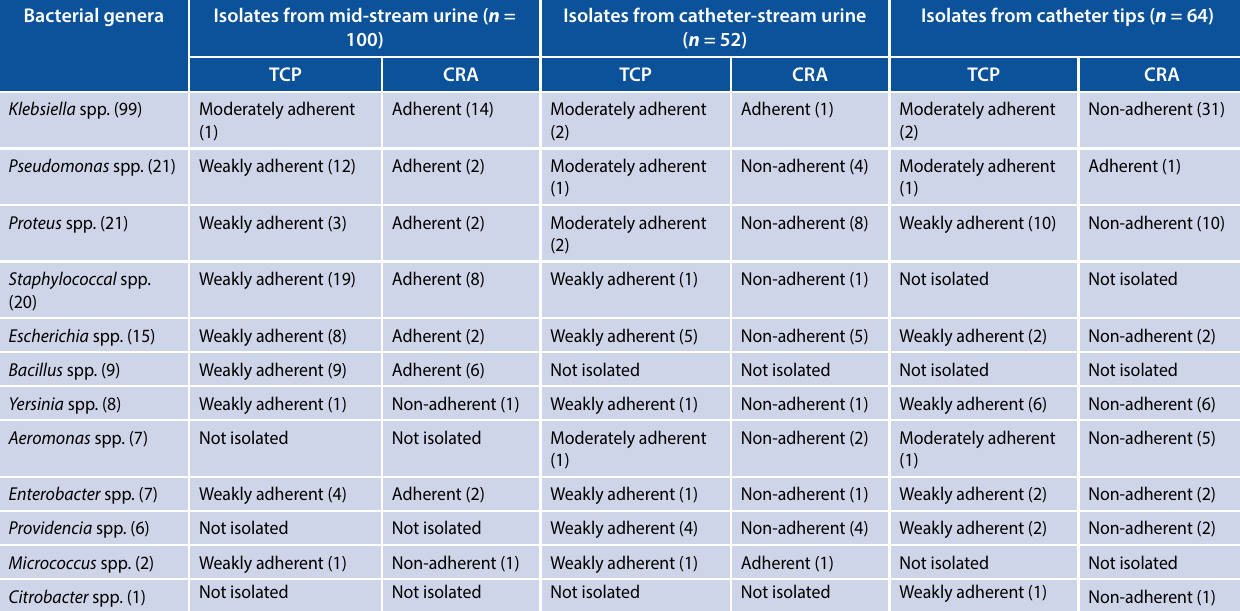
Table 2: Results of biofilm formation of bacterial isolates from mid-stream urine, catheter-stream urine and catheter tips using the tissue culture plate (TCP) and Congo red agar (CRA) methods Bacterial